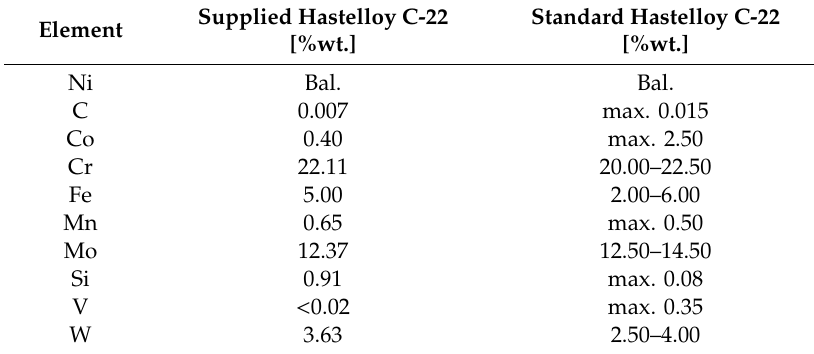
Table 1. Composition of Hastelloy